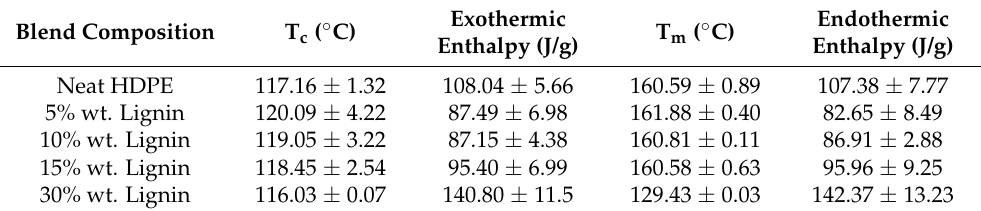
Table 3. DSC test results.